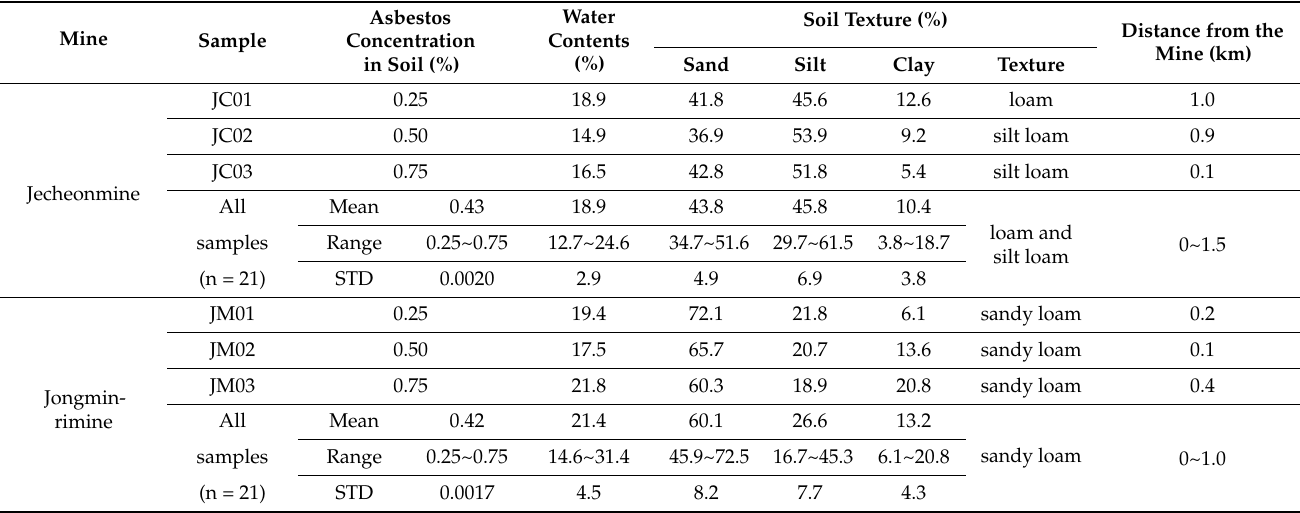
Table 1. Asbestos concentrations, water contents, and soil texture of soils sampled from the Jecheon and Jongmin-ri